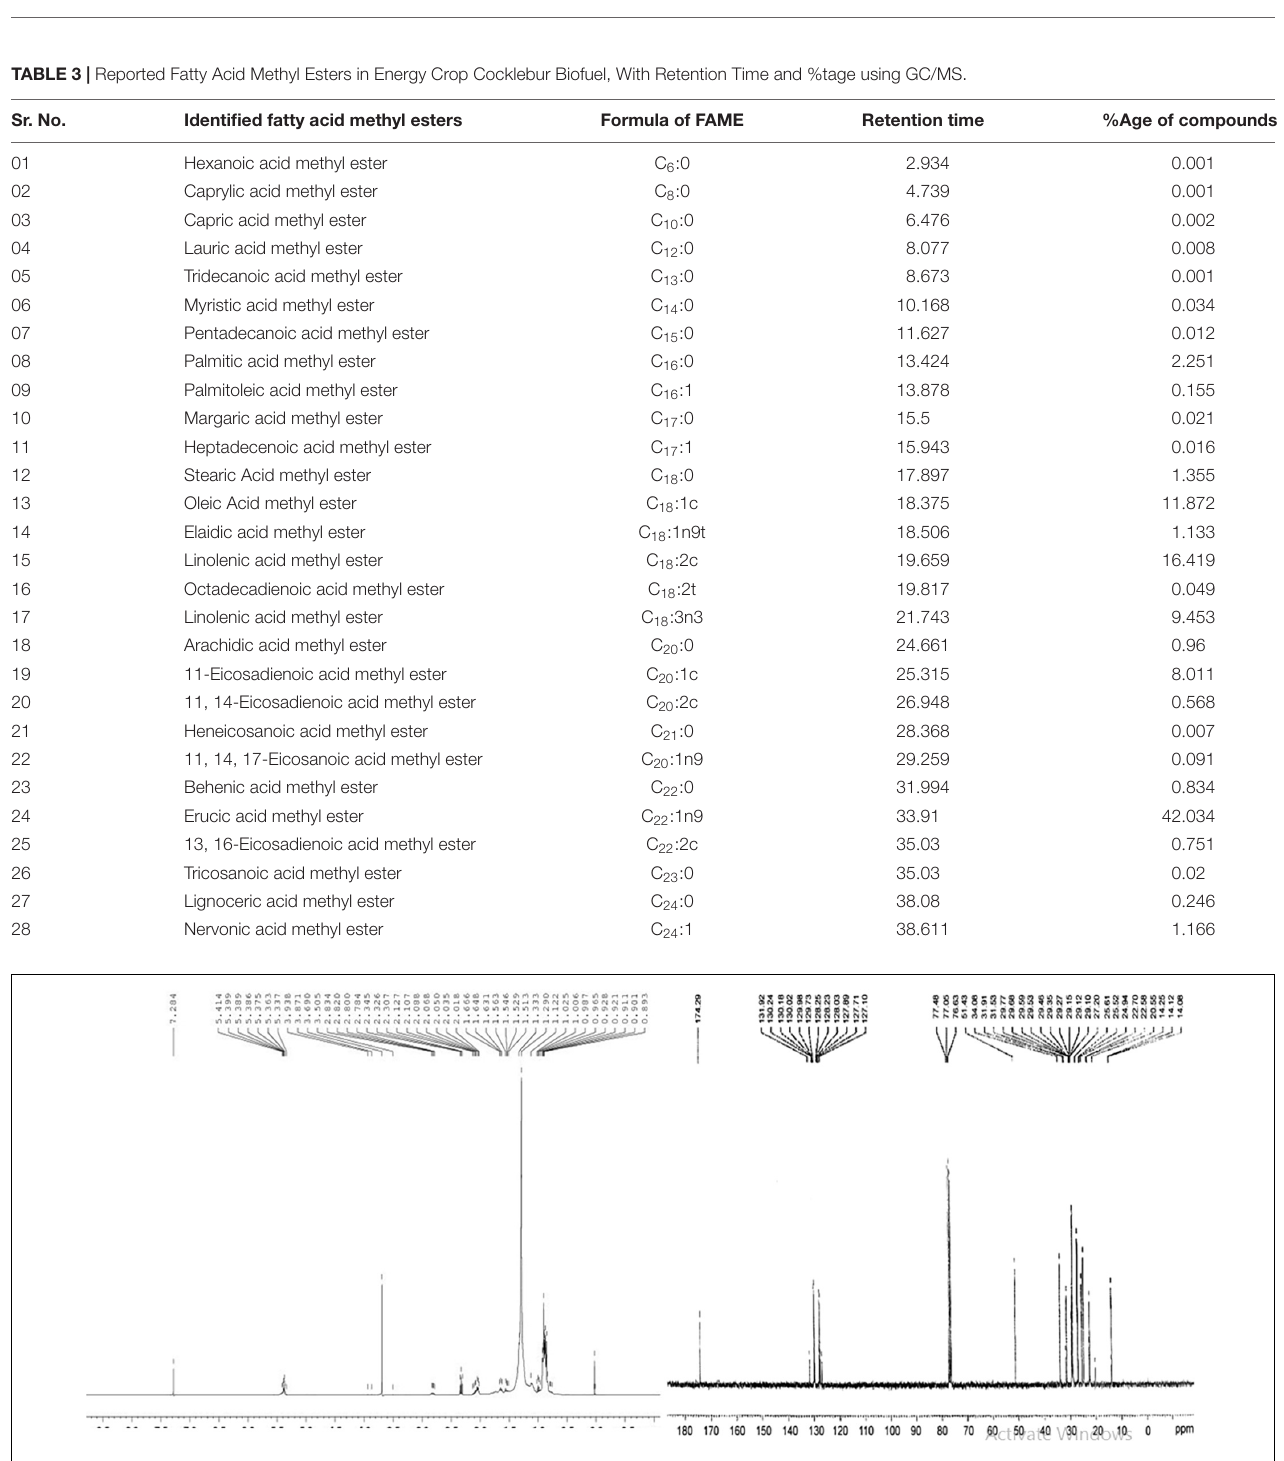
FIGURE 10 | (A,B) 1 H NMR and 13 C NMR Spectrum Showing Various Absorption Peaks in Energy Crop Cocklebur Methyl